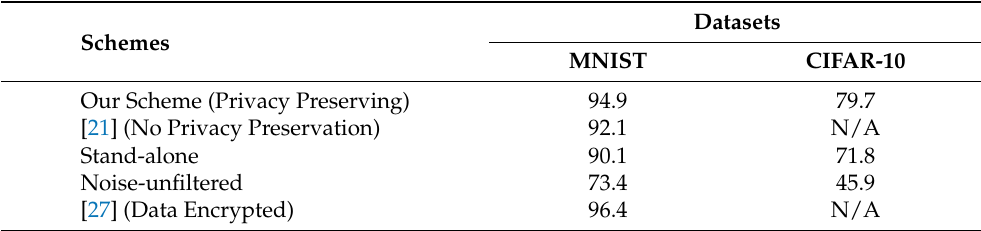
Table 1. Validation Accuracy Comparison.